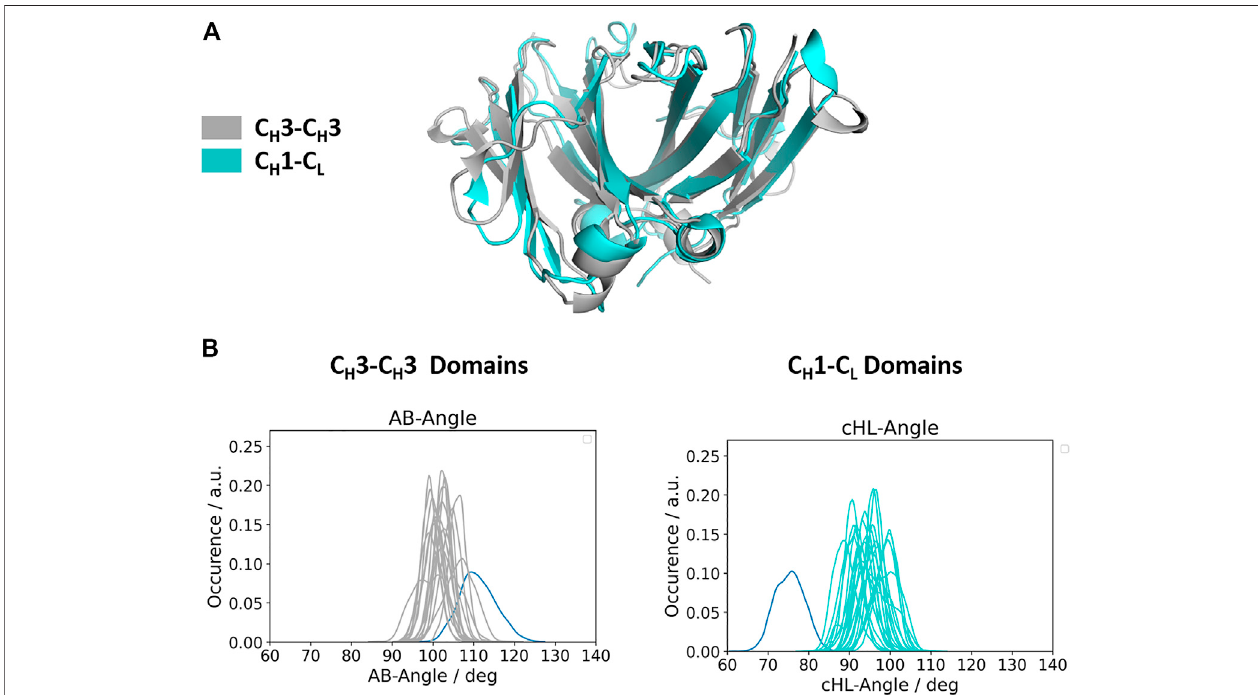
FIGURE2| ComparisonofthestructurallyhighlysimilarC H 3-C H 3andC H 1-C L domains. (A) StructuraloverlayofaC H 3-C H 3(grey,PDB:3AVE)andaC H 1-C L (cyan, PDB:5I19)dimerillustratingtheiridenticalscaffold,despitehavingdivergingloopstructures. (B) DistributionsofinterdomainanglesforallC H 3-C H 3andC H 1-C L domains, respectively. These angles haven been calculated with the recently published OCD tool and show that the C H 3-C H 3 interfaces cover narrower angle ranges, while the C H 1-C L , due to their higher number of sequence variations, reveal a larger spread. The highlighted distributions shown in blue correspond to the C H 3-C H 3 heterodimeric DE-KK variant (PDB: 5NSC) and to the λ -light chain antibody (PDB: 1NL0).